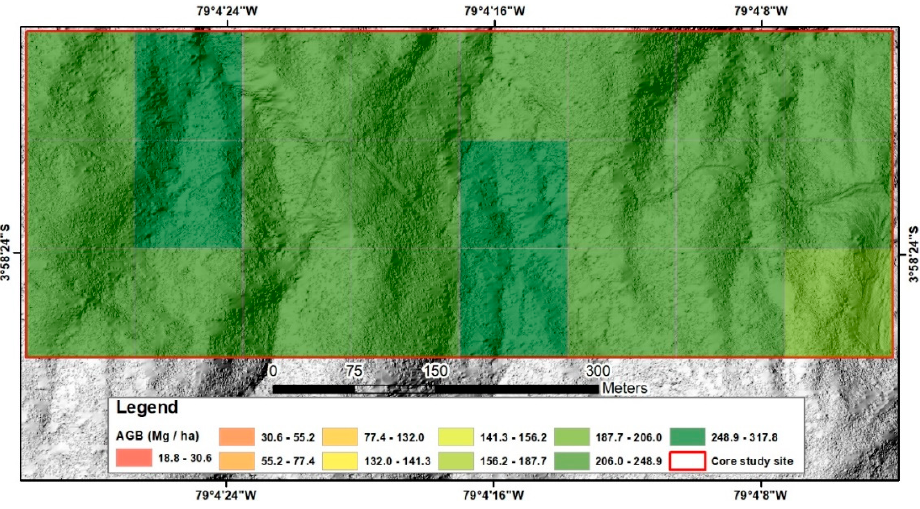
Figure 8. AGB estimation by means of multispectral data.